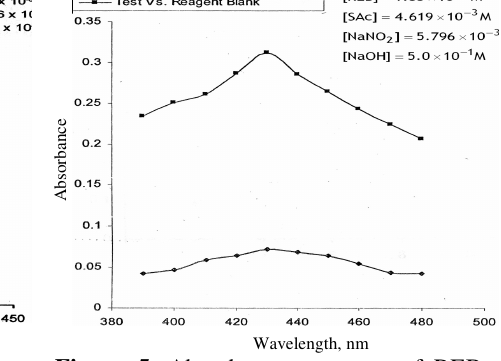
Figure 5. Absorbance spectrum of REB – SAc – HNO